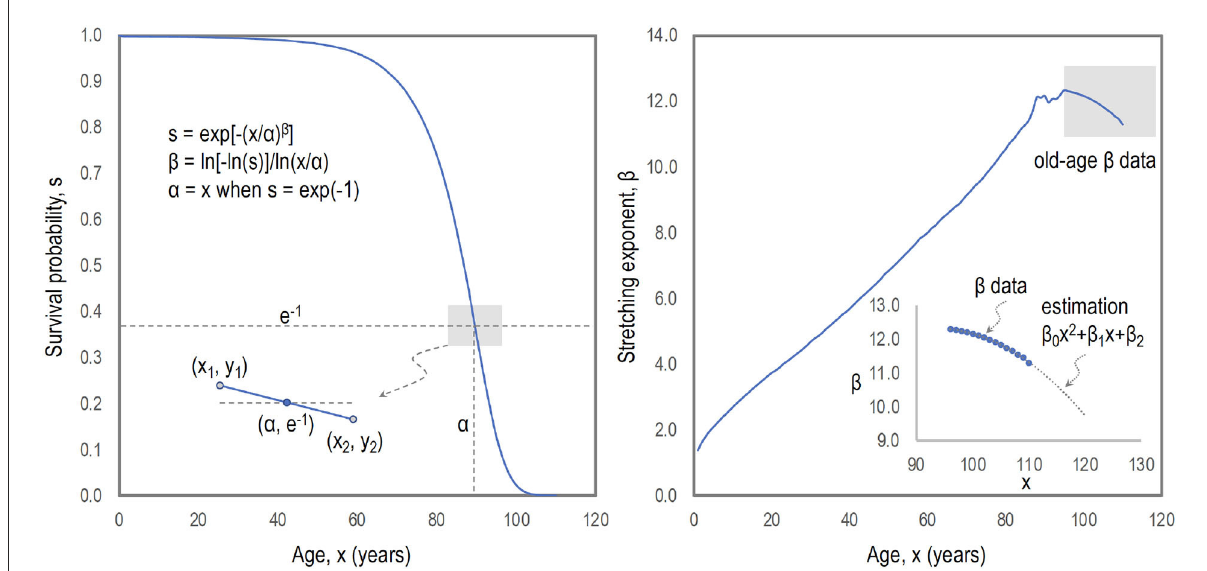
FIGURE1 Mathematics of survival curves. Human survival curves can be plastic and tend to be almost rectangular. Such plasticity and rectangularity can be described by adopting the modified stretched exponential model as s ( x ) = exp[ − ( x /α ) β ( x ) ] featured with the characteristic age α for s ( α ) = e − 1 (the crossover of s ( x ) and e − 1 ) and the age-dependent stretched exponent β ( x ). The age dependence of the stretched exponent at extreme ages (over 100 years) is described as a quadratic model of β ( x ), which is realistic regarding the plasticity and rectangularity of human survival